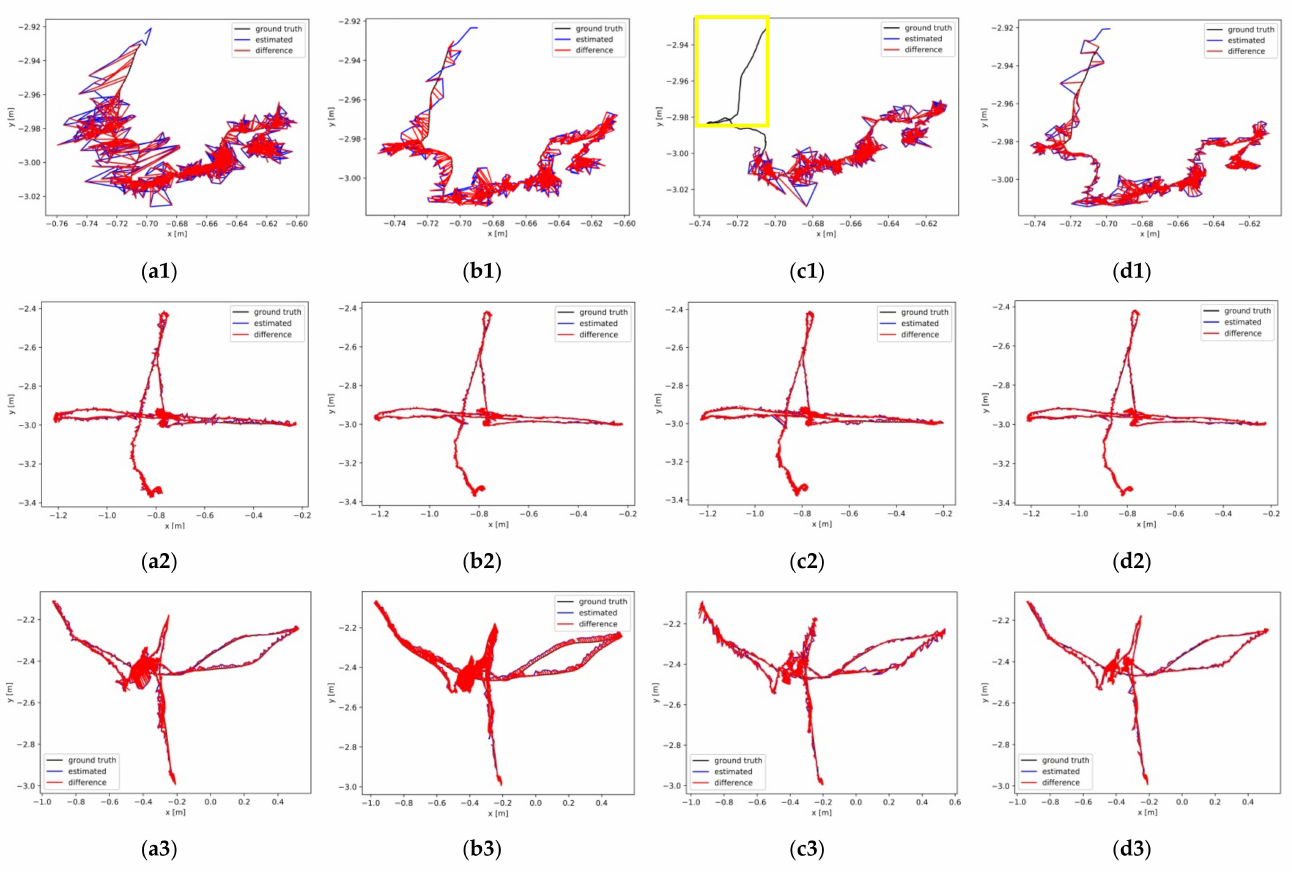
Figure 12. Comparisons of ATE-RMSE on three low dynamic sequences, ” fr3_sitting_static , fr3_sitting_xyz , fr3_sitting_halfphere ”. ( a1 – a3 ) OPF-SLAM; ( b1 – b3 ) ORB-SLAM2; ( c1 – c3 ) Dyna-SLAM; ( d1 – d3 )